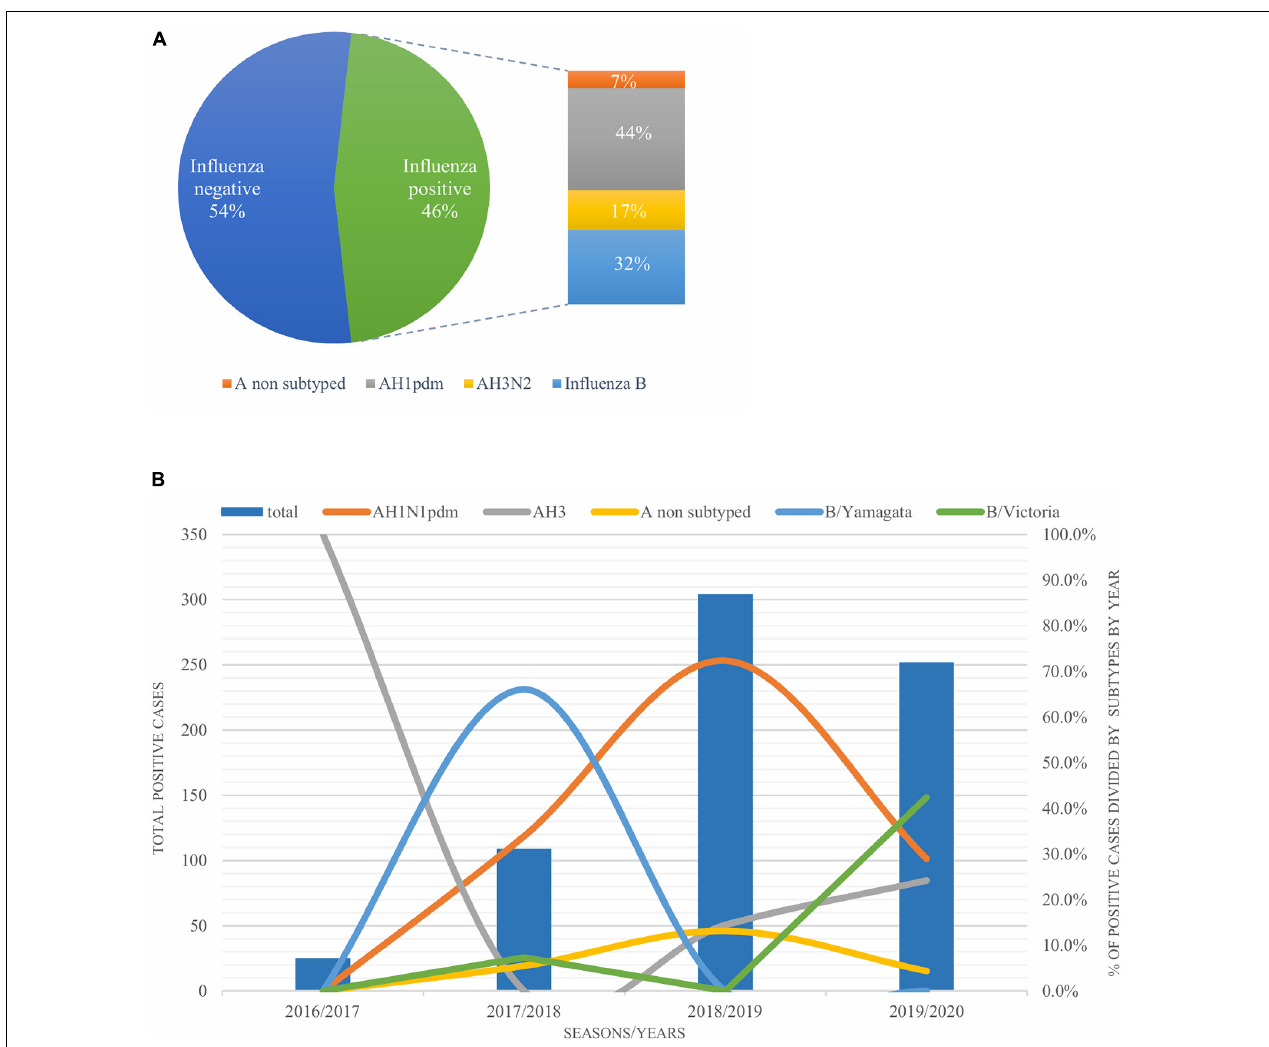
FIGURE 1 | (A) Percentage of influenza types and subtypes from ILI and SARI surveillance (2016–2020). (B) The total number of influenza positive samples per year is presented by blue bars. Annual percentages of reported positive cases for influenza A subtypes H1N1pdm09 (orange), H3N2 (gray) and influenza B/Victoria (green) and B/Yamagata (blue) are also